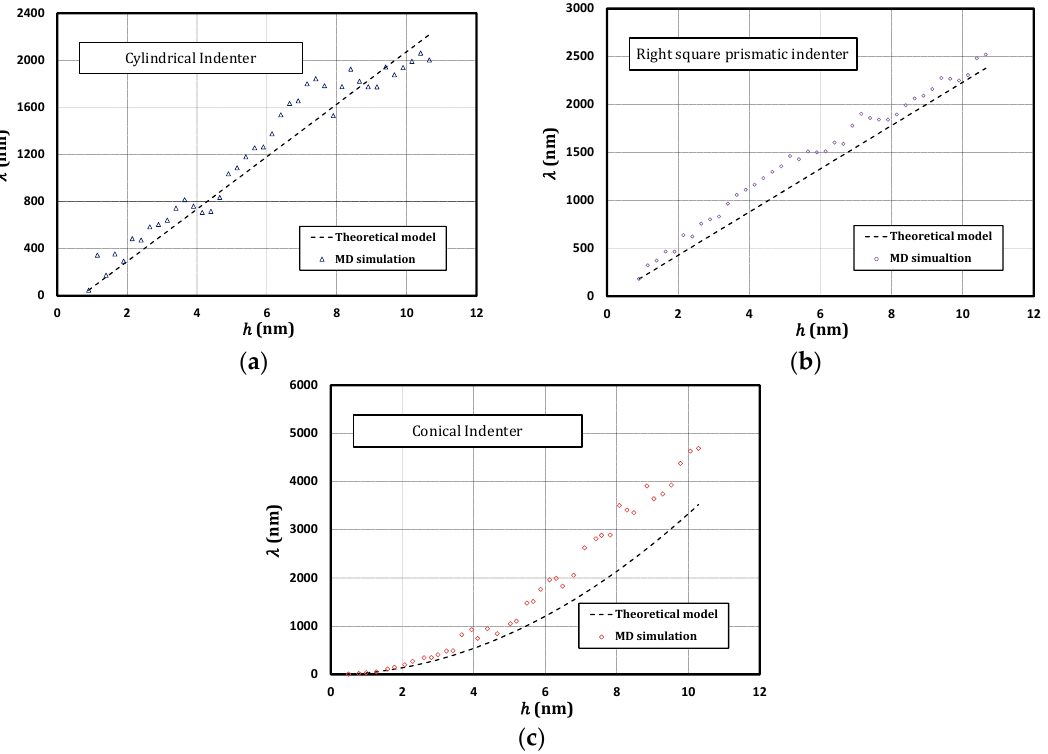
Figure 18. Total dislocation length obtained from the simulation and theoretical models of Nix and Gao [13], Swadener [14] and Pugno [90] in samples indented by the ( a ) cylindrical indenter, ( b ) right square prismatic indenter and ( c ) conical indenter (after Voyiadjis and Yaghoobi [86]).